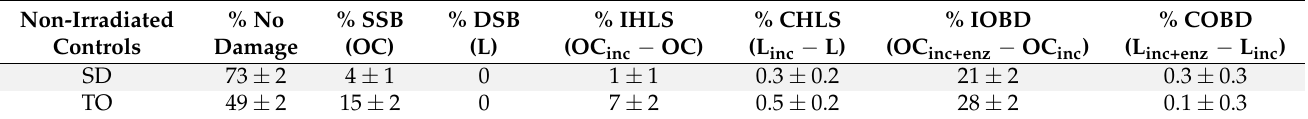
Table 2. Percentage of DNA damage computed from the yields in Table 1. Uncertainties represent the sample standard deviation.